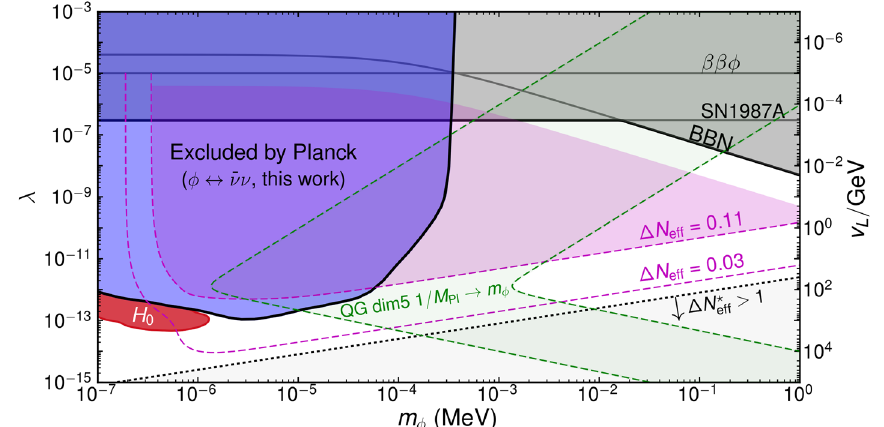
region of parameter space in which the majoron mass could arise from dim-5 Planck suppressed operators (3). Shown in blue is the parameter space excluded in this work using Planck2018 data at 95% CL. The parameter space below the black dotted line is excluded if there was a smallbutprimordialpopulationofthermalmajorons.Theregionlabeled ‘ H 0 ’ is the preferred 1 σ contour for resolving the Hubble